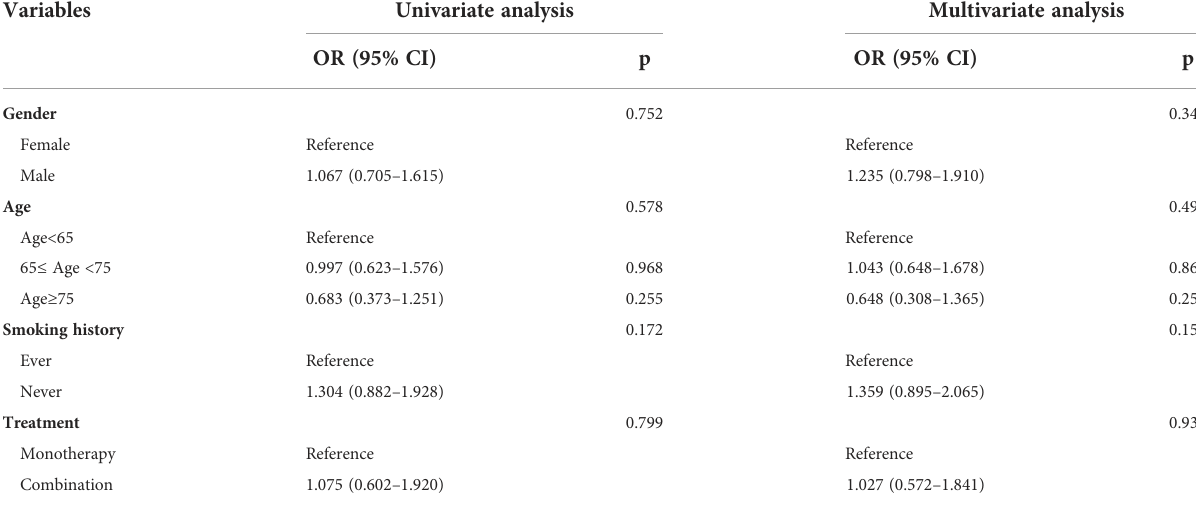
TABLE 3 Univariate and multivariate analyses of each factor ’ s ability in predicting PFS for 114 EGFR-mutated patients receiving ICIs.